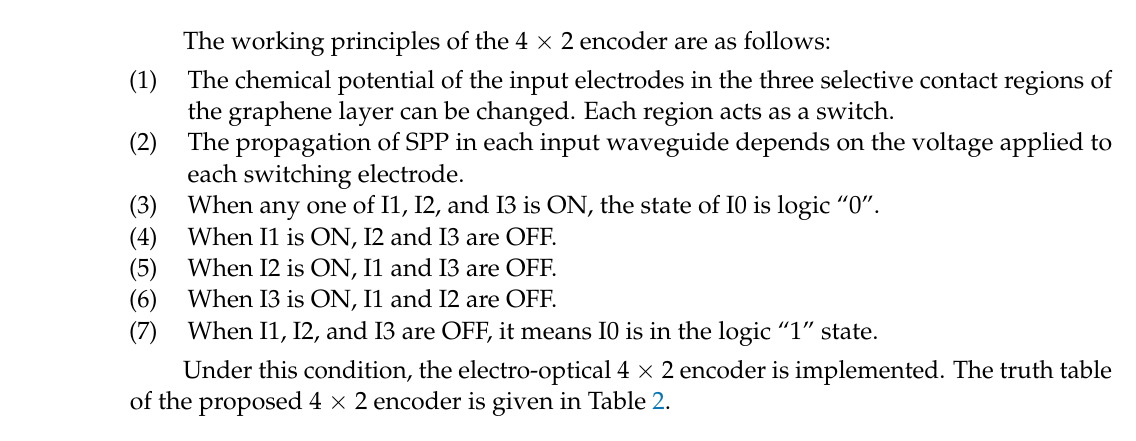
Figure 6. W1 = 100 nm and λ = 9.3 μ m. ( a ) Normalized transmission coefficient of the three-branch graphene-based light splitter as a function of W2. ( b ) The value of K for the three-branch graphene- based light splitter as a function of W2. ( c ) When only I1 is “ON”, the transmission coefficient of Y0 at the output of the proposed 4×2 encoder as a function of L2. ( d ) The transmission coefficient of Y0 at the output of the proposed 4×2 encoder as a function of L2 when only I3 is “ON”. The inset illustrates the z-component of the electric field distribution confined within the dielectric layer.